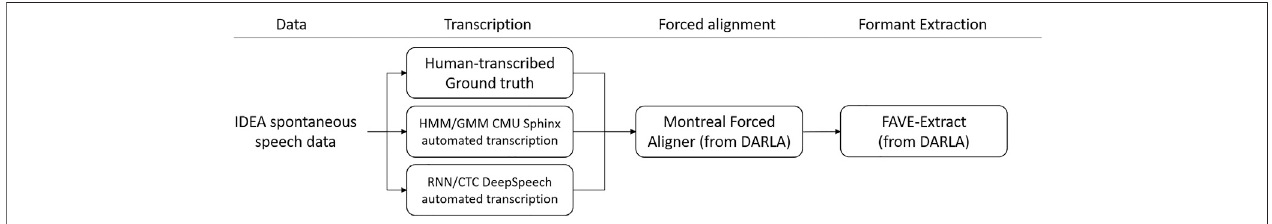
FIGURE 1 | Work fl ow for data